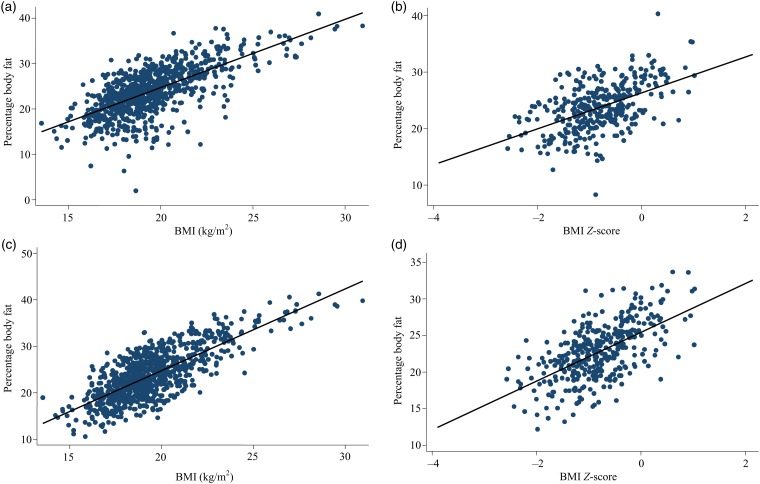
Scatterplot between BMI and body fat percentage by different methods in different age
groups: (a) percentage fat by the bioelectrical impedance analysis (BIA) method in
women ≥20 years of age; (b) percentage fat by the BIA method in women <20 years
of age; (c) percentage fat by the skinfold method in women ≥20 years of age; (d)
percentage fat by the skinfold method in women <20 years of age.